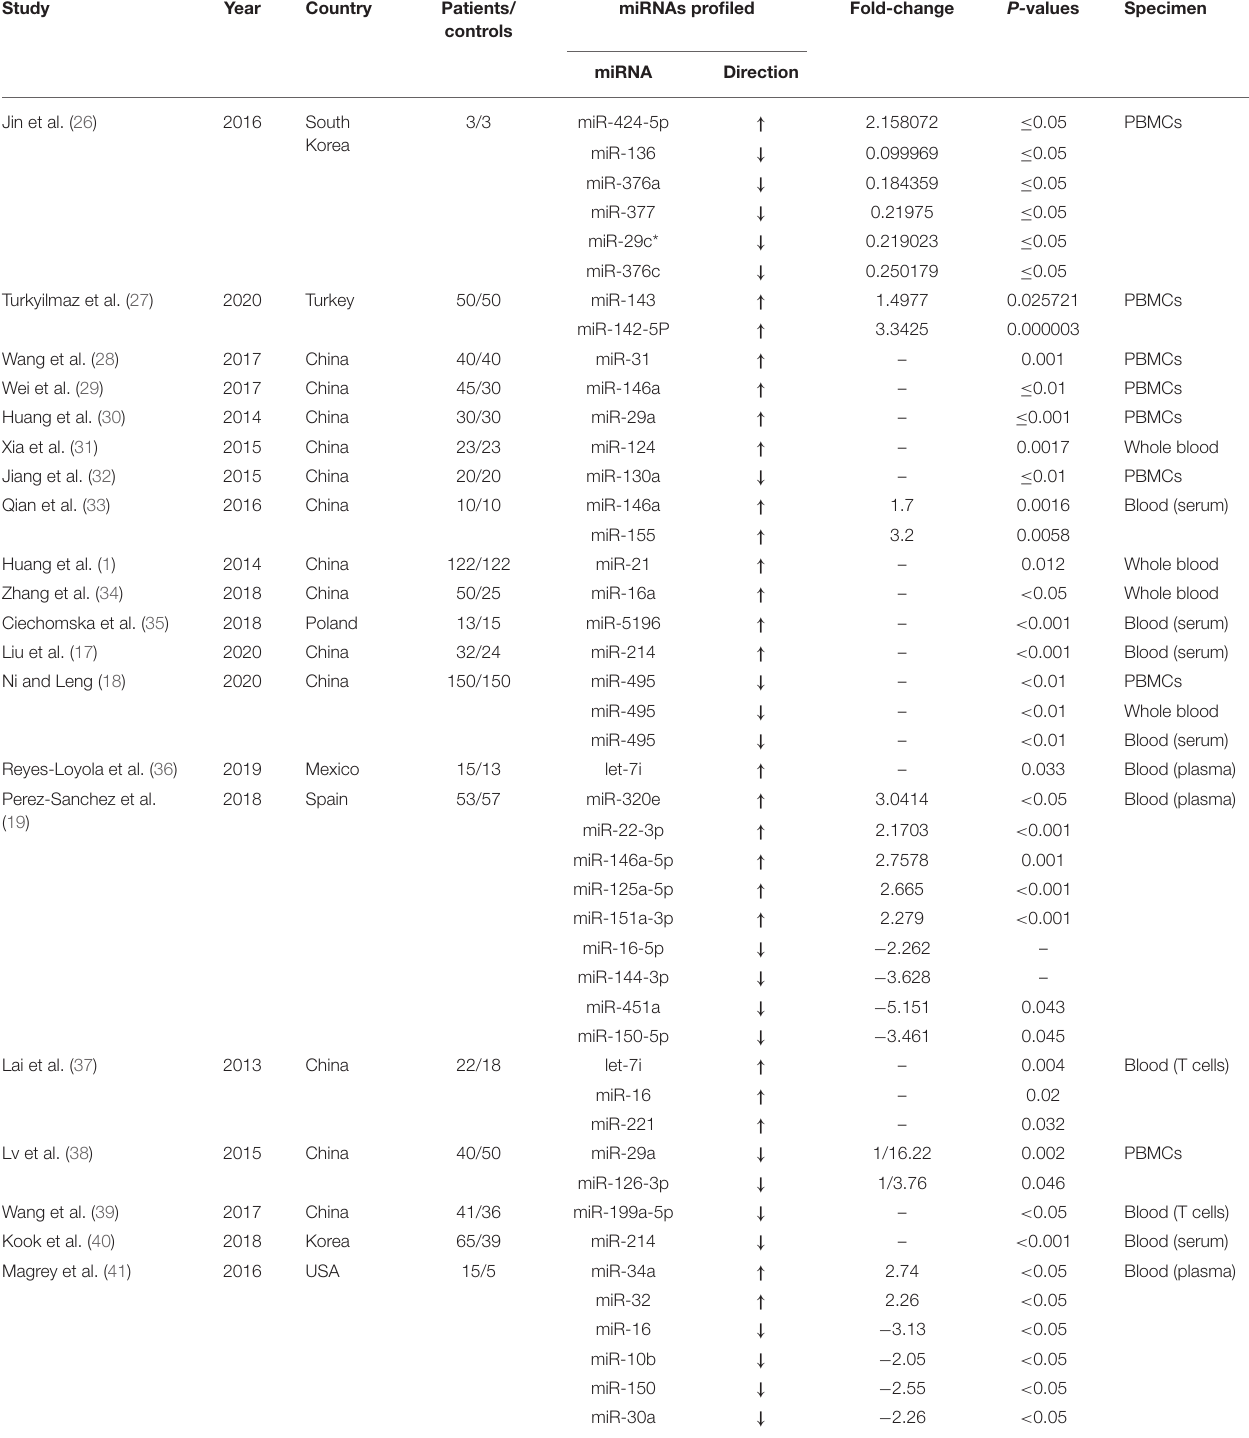
TABLE 1 | Characteristics of studies included in systematic